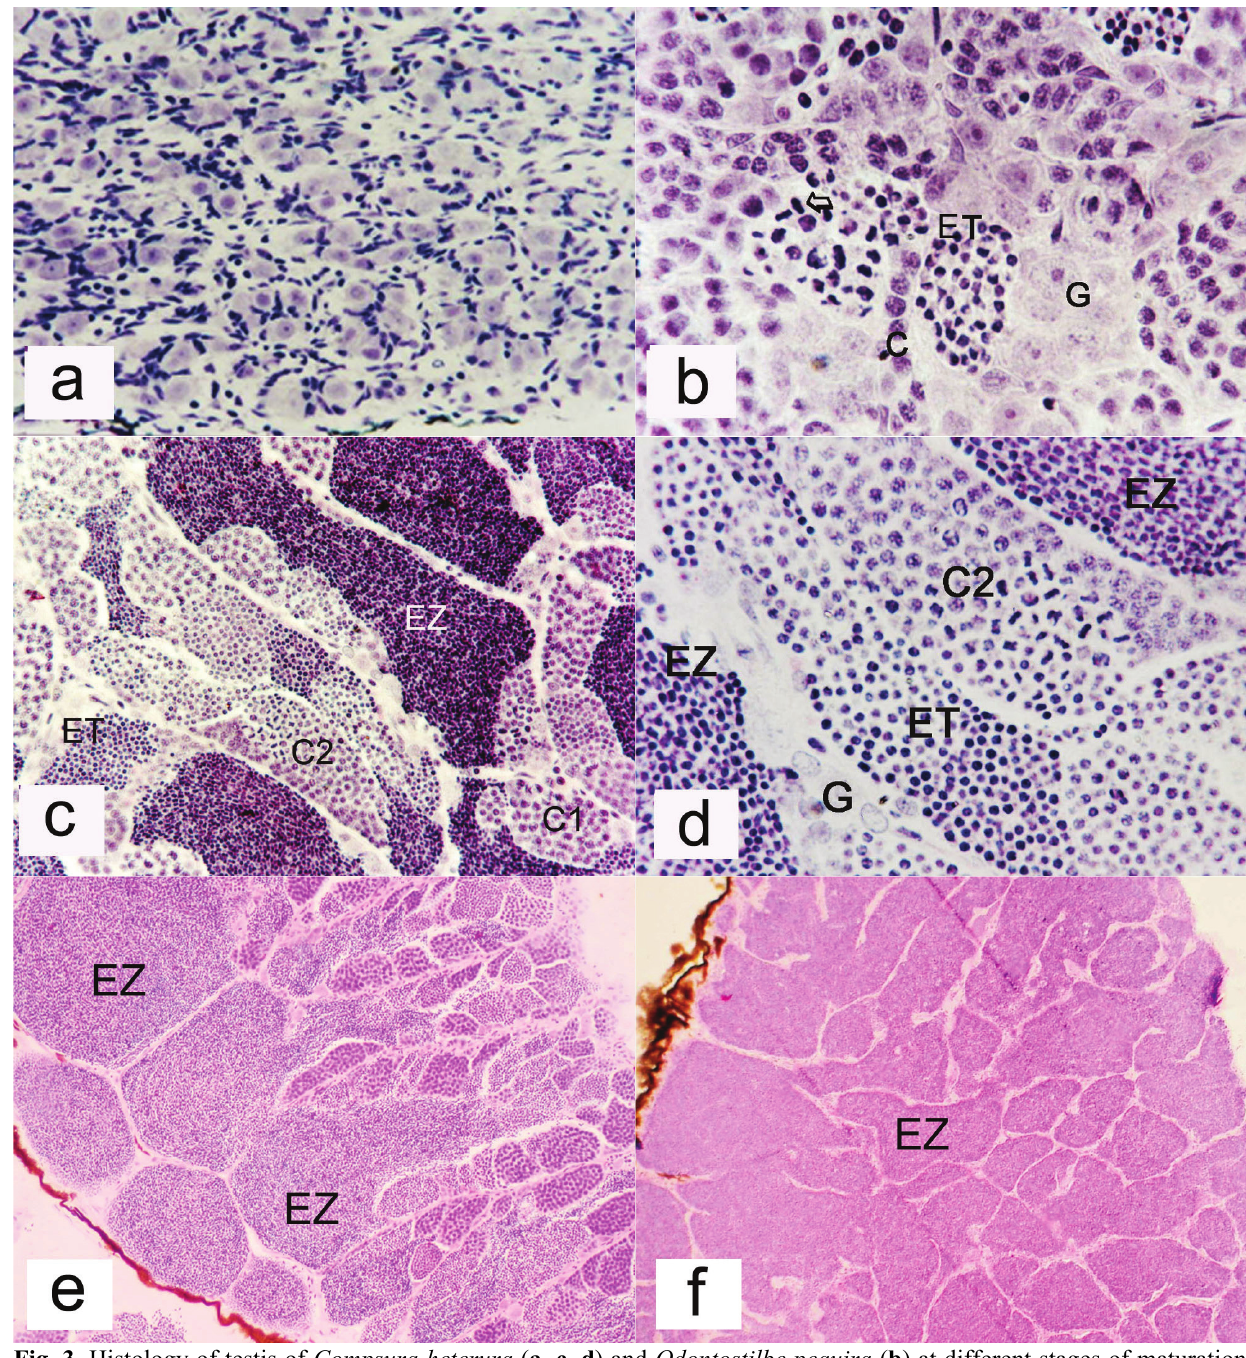
Fig. 3. Histology of testis of Compsura heterura ( a , c , d ) and Odontostilbe pequira ( b ) at different stages of maturation: immature ( a ), maturing ( b , c , d ) mature ( e , f ). Arrow - cell division, C - spermatocytes, C1 - primary spermatogonia, C2 - secondary spermatogonia, ET - spermatids, EZ - spermatozoa, G - spermatogonia. Magnification 40x ( a , c ), 100x ( b , d ), 20x ( e , f